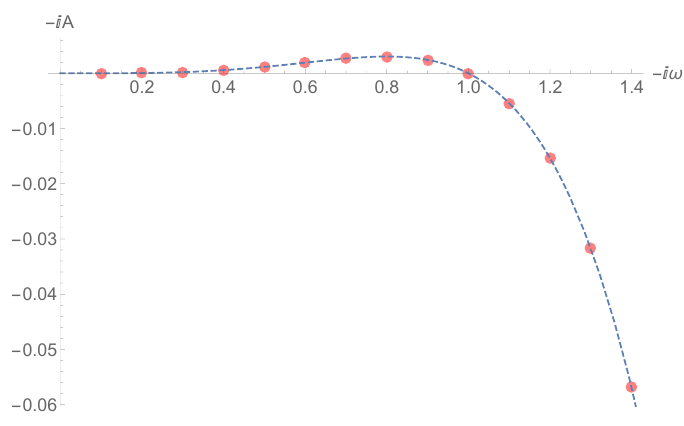
computed for ! 2 i R > 0 and 1 ! 3 = !! 1 ! 2 ! 3 (1 + i! ) 1 ! 3